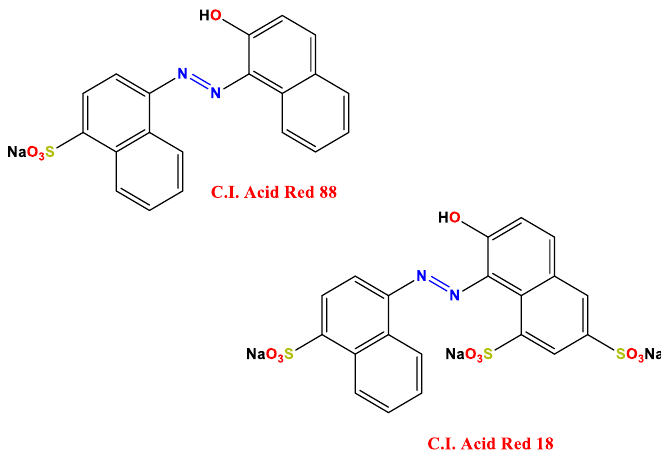
Figure 3. Chemical structure of the dyes. Adapted from Reference